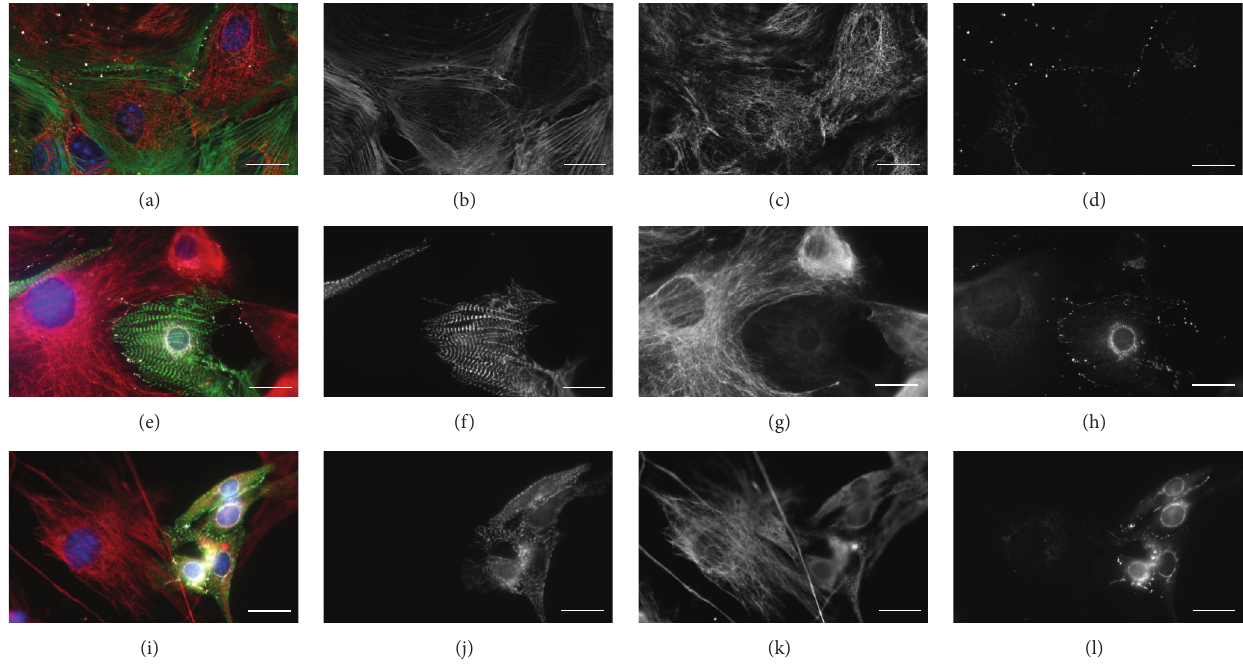
Figure 1: Cultured aCFs showed a myofibroblast phenotype and distribution of Cx43 in cocultures of ESC-CMs with aCFs and MSCs. Cultured aCFs (a–d), ESC-CMs, and aCFs after coculture (e–h) and ESC-CMs and MSCs after coculture (i–l). Merged picture of the different channels (a, e, i) as well as 𝛼 -smooth muscle actinin (b), sarcomeric 𝛼 -actinin (f, j), vimentin (c, g, k), and Cx43 (d, h, l). Scale bars = 20 𝜇